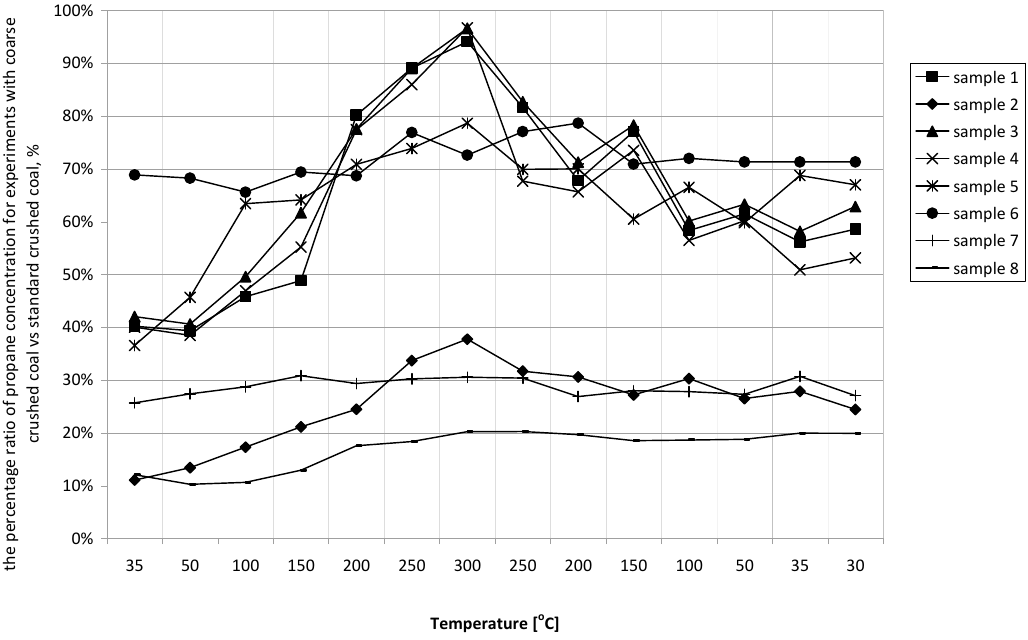
Figure 5. The course of changes in the ratio of released propane (for both coarse and standard crushing) in the stages of heating and cooling of coal samples.